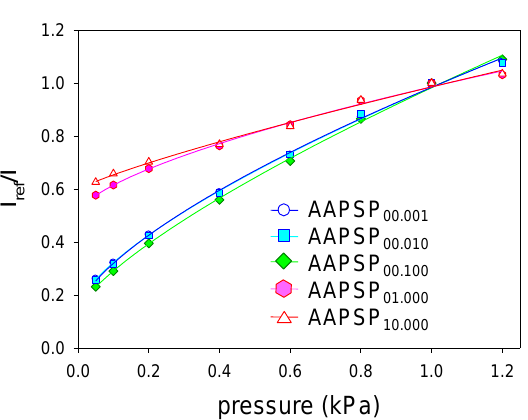
Figure 6. Pressure calibration